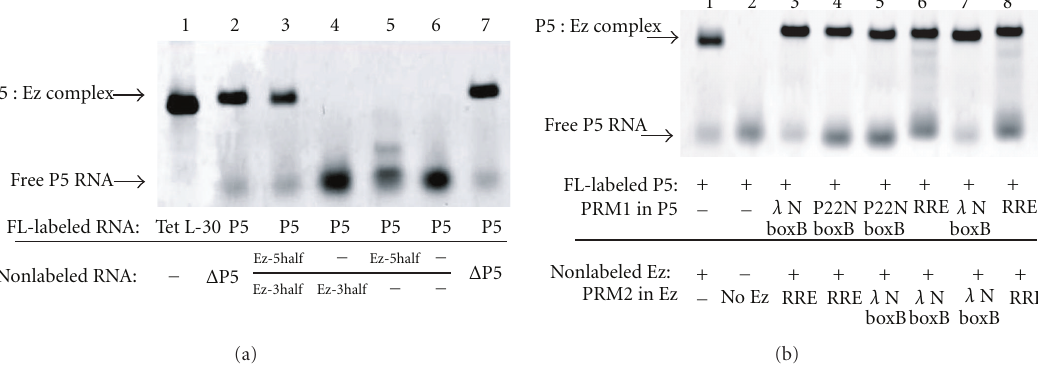
Figure 3: Gel mobility shift assay of the two-piece Tetrahymena RNA consisting of three RNA molecules. (a) The Tet L-30 RNA and a bimolecular derivative (P5 + Δ P5) were used as positive controls. Electrophoresis was carried out with 10 mM Mg 2+ ions. To visualize RNA molecules on the gel, the 3 (cid:2) ends of FL-labeled RNAs were labeled with BODIPY. (b) Influence of PRM1 and PRM2 on the P5:Ez complex formation. Electrophoresis was carried out with 10 mM Mg 2+ ions. To visualize RNA molecules on the gel, the 3 (cid:2) ends of FL-labeled RNAs were labeled with